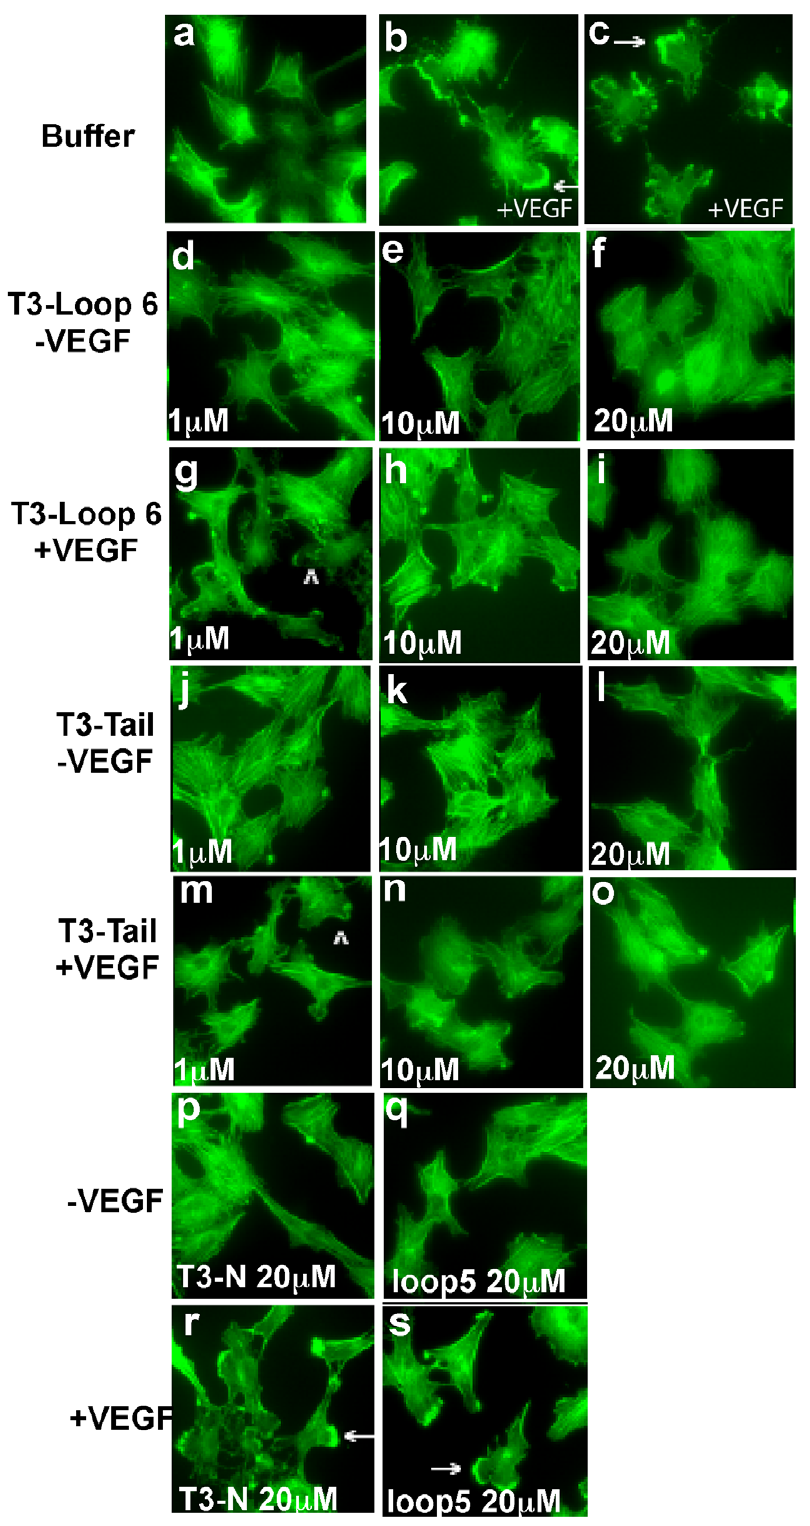
Figure 5. Effects of TIMP-3 peptides on VEGF-mediated actin reorganization. TIMP-3 loop 6 and tail but not loop 5 and N-peptide inhibit VEGF-induced actin reorganization in PAE/KDR cells. Quiescent cells were stimulated with (b,c,g,h,i,m,n,o,r,s) or without (a,d,e,f,j,k,l,p,q) 50 ng/ml VEGF in the presence or absence of increasing concentrations of loop 6 (d-i) and tail peptides (j-o) or 20 m M loop 5 (q,s) or N-peptides (p,r) for 30 min at 37 u C. Cells were permeabilized and stained with fluorescein isothiocyanate-phalloidin, as described under ‘‘Materials and Methods’’. The arrows indicate membrane edge ruffling in the stimulated cells. Magnification, 6 1000.